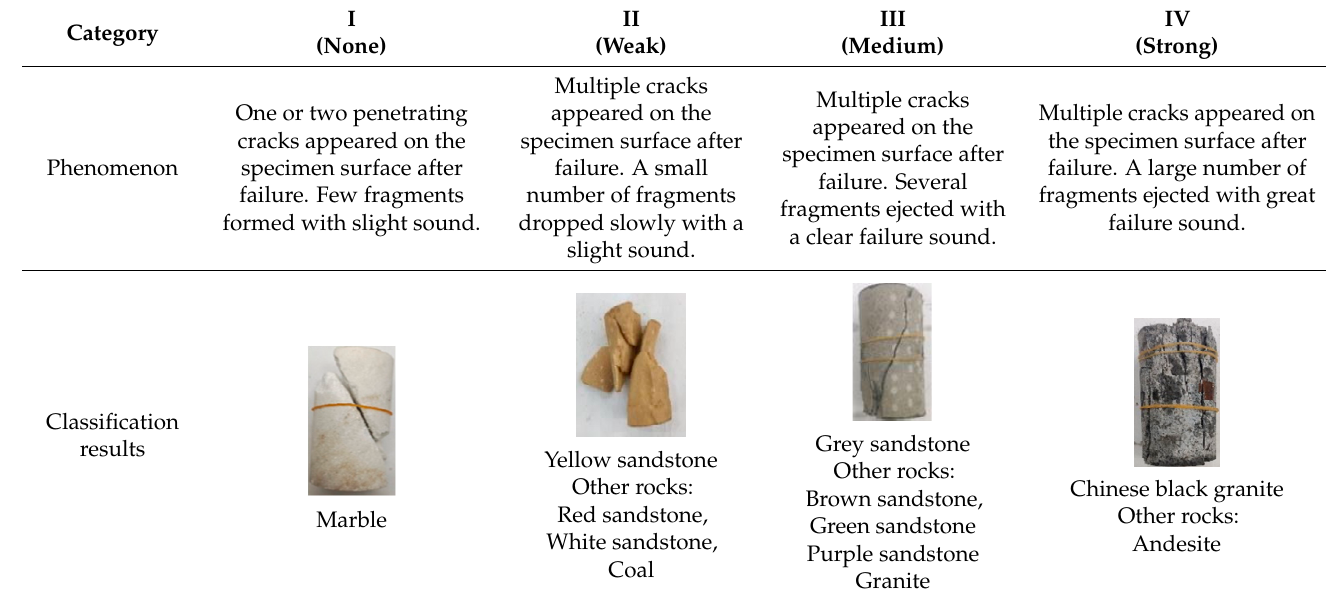
Table 5. Calculation results of B 1 , B 2 , and SDR.